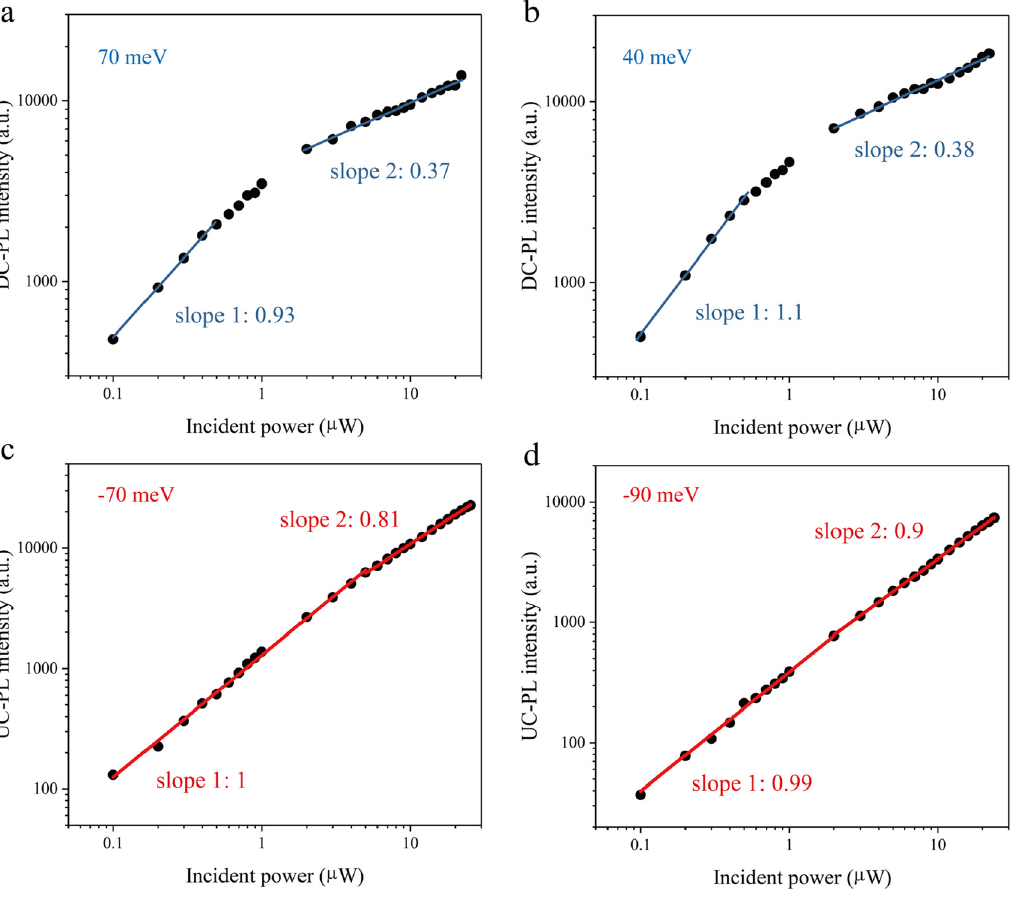
Figure3: Power-dependentphotoluminescence(PL)intensityindownconversion(DC)PLandupconversion(UC)PL.(a),(b)TheDCPLintensity shows a saturated trend. (c), (d) The slope of UC PL intensity persists under high incident